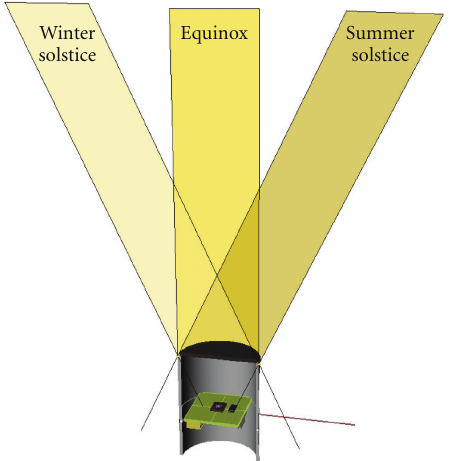
Figure 6: Ray incidence on slit sensor.